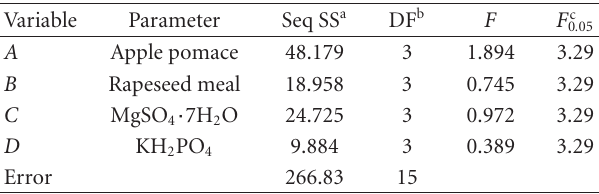
Table 7: Analysis of variance of orthogonal design results for the optimization of strain Hhs.015 T alternative culture medium.